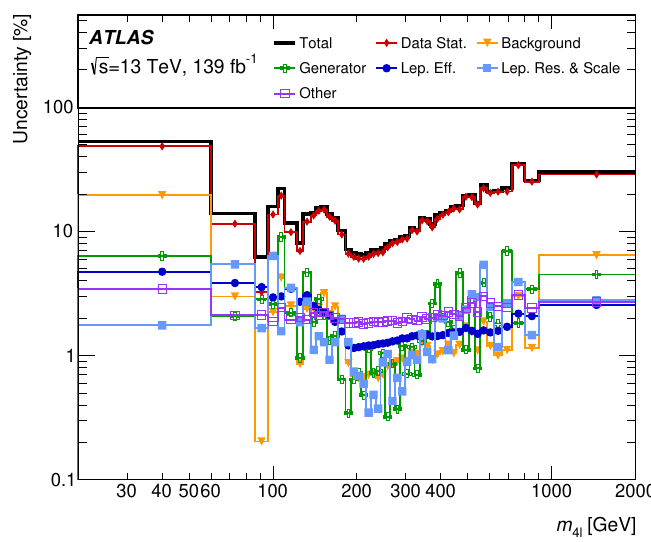
Figure 4 . Uncertainty breakdown of the measured cross-section as a function of m 4 ‘ . “Lep. Eff.” refers to the uncertainties in the lepton efficiencies, “Lep. Res. & Scale” refers to the uncertainties in the lepton resolutions and scales, and the theory uncertainties are included in the “Generator” uncertainty. Contributions from the Monte Carlo statistical uncertainty and uncertainties in the luminosity and the inelastic cross-section are included in